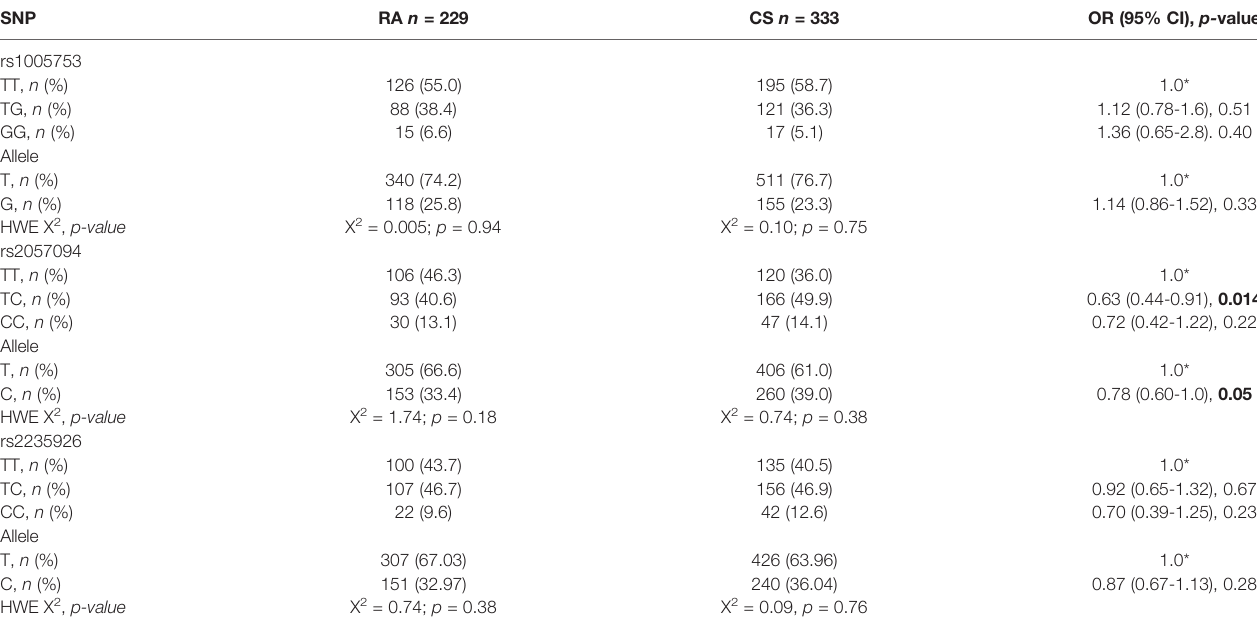
TABLE 3 | Genotypic and allele frequencies of polymorphisms in PADI2 gene.